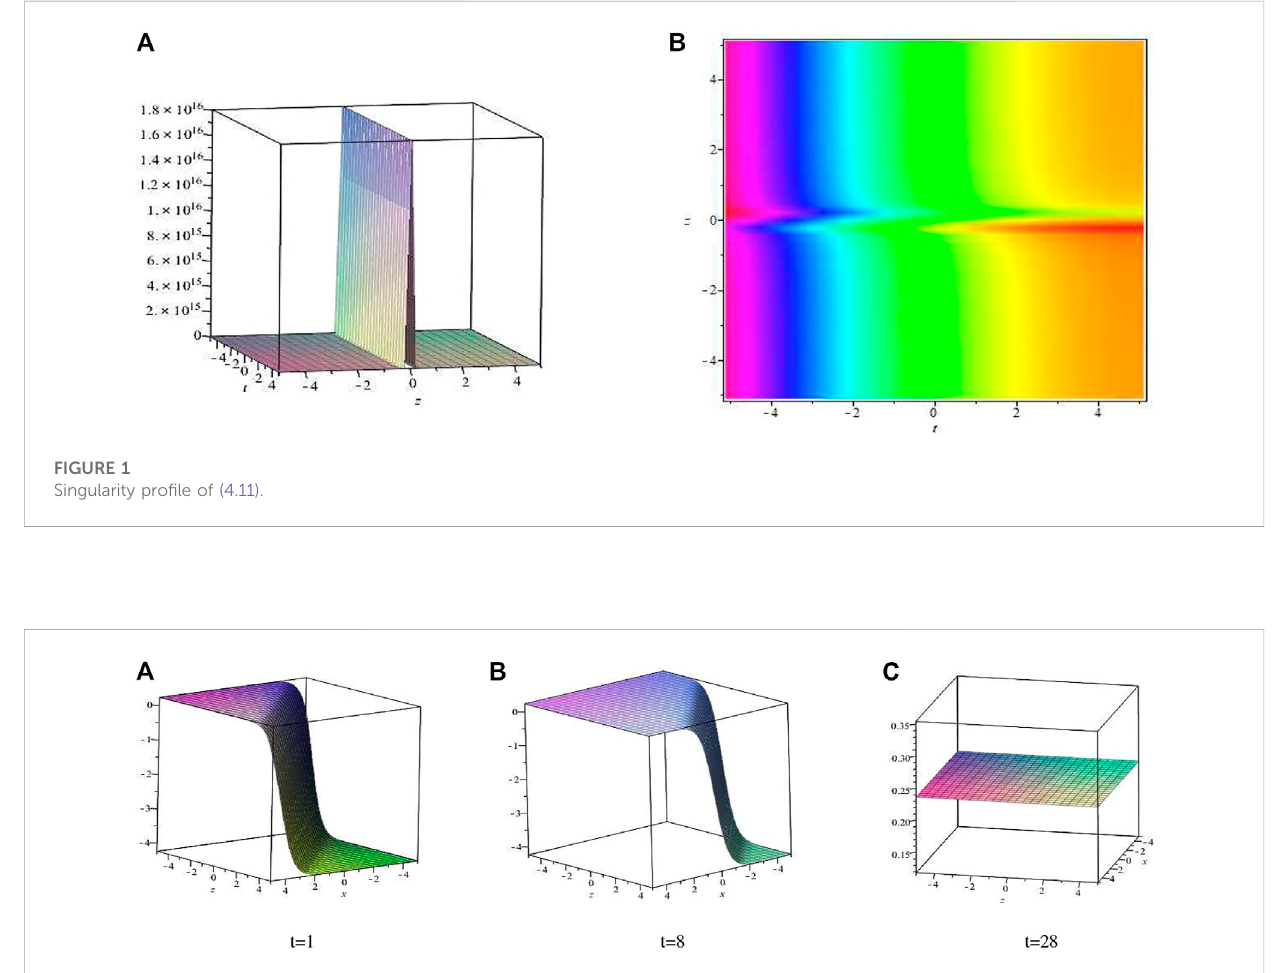
FIGURE 2 Annihilation of the kink wave solution of (4.34) at y =1.